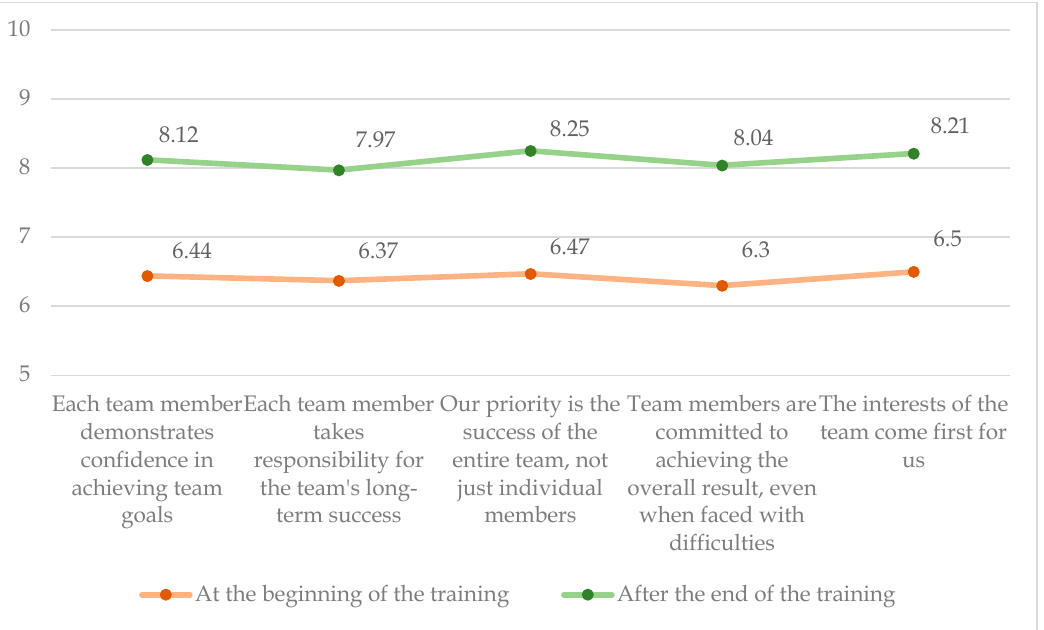
Figure 3. Results of answers to the block of questions “Formation of commitment to the overall result” (in comparison of answers to questions at the beginning and after the end of the training).